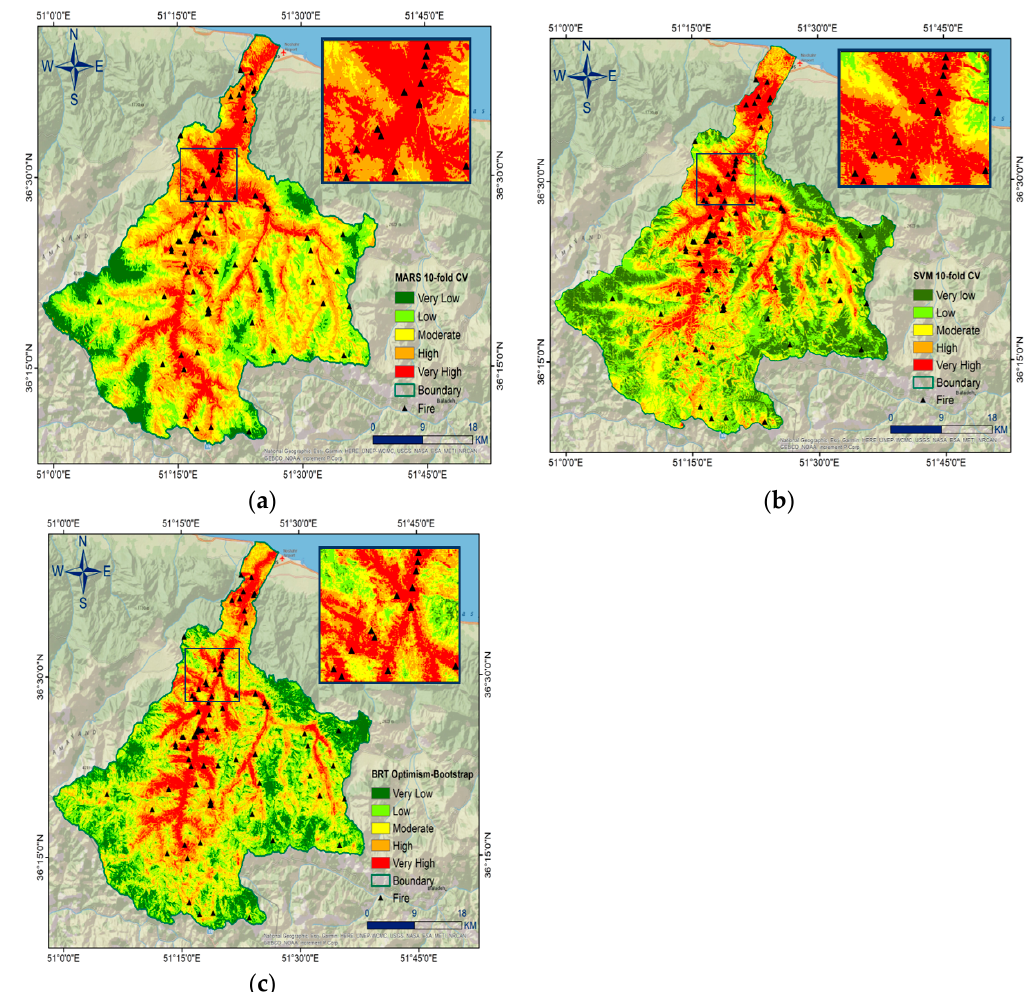
Figure 5. Forest fire susceptibility maps produced with ( a ) MARS 10-fold CV ( b ) SVM 10-fold CV and ( c ) BRT optimism bootstrap.